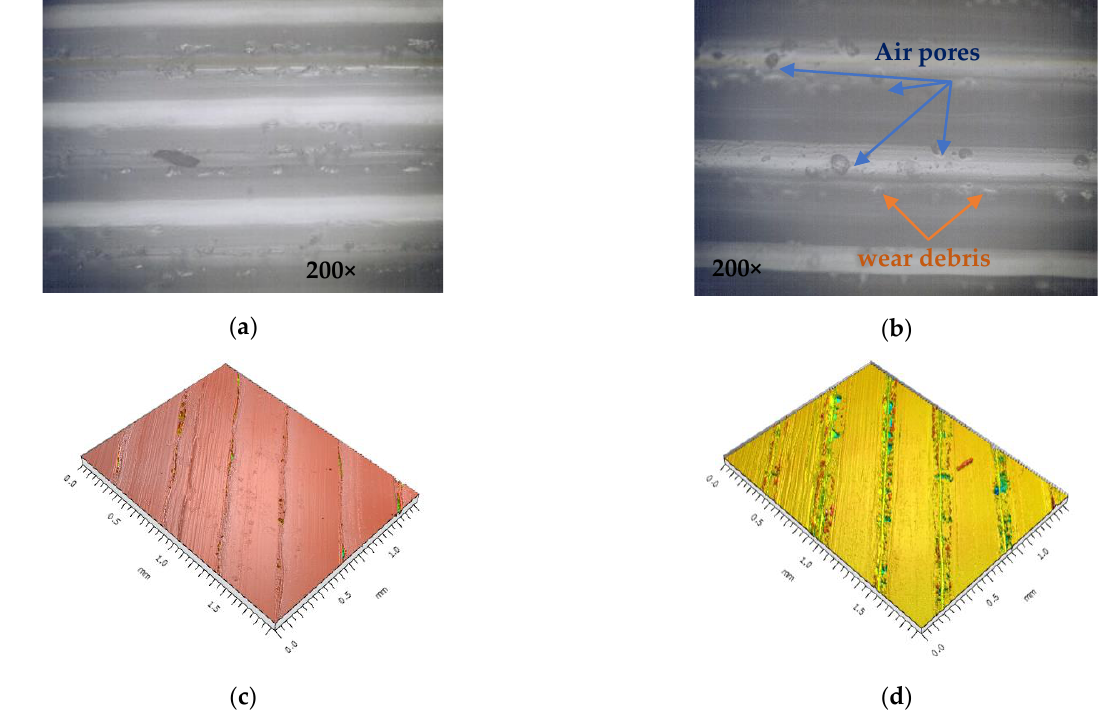
Figure 20. Surface analysis: ( a , c ) PLA, blue ink, colour distribution 33%, infill 15%; ( b , d ) PLA+, green ink, colour distribution 33%, infill 15%.